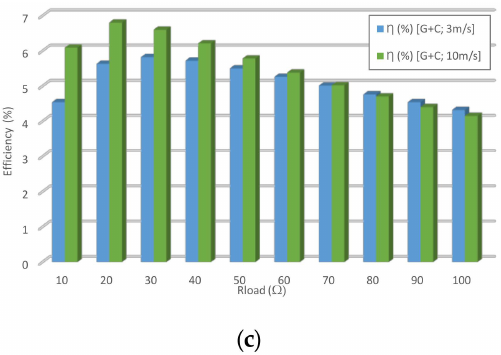
Figure 31. Output power, voltage and e ffi ciency values with di ff erent resistive loads at 3 m / s and 10 m / s wind velocities. ( a ) Pout (mW). ( b ) Voltage (V). ( c ) E ffi ciency of the system (%): Generator + Conversion